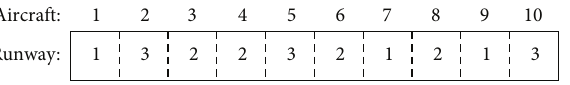
Figure 1: The representation of the candidate